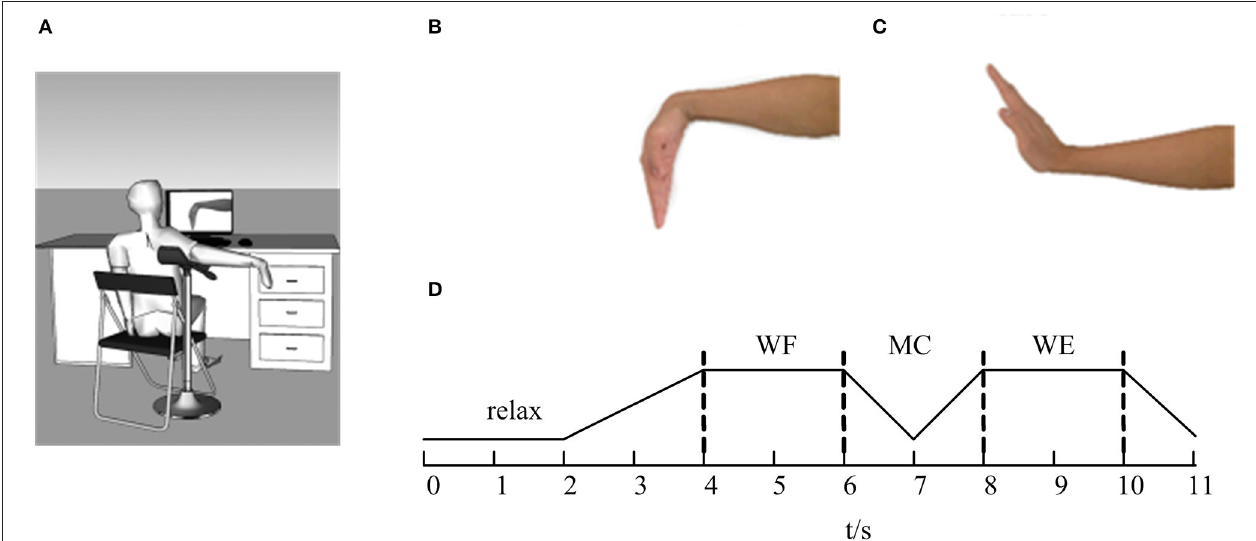
FIGURE 1 | The diagram of the experiment. (A) The sketch of the experiment. (B) Wrist flexion (WF). (C) Wrist extension (WE). (D) The flow of the task. The line represents the maintenance phase, and the dotted lines represent the state transitions.